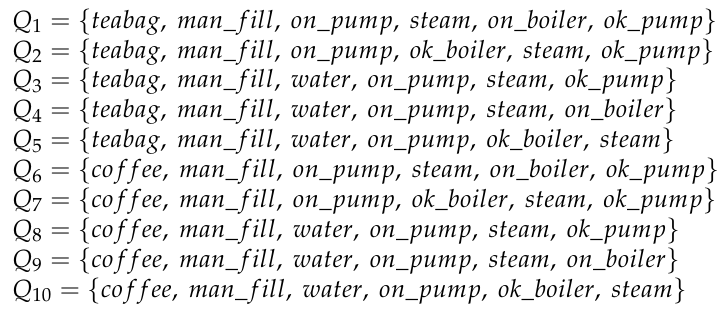
Figure 1. Knowledge Base for the espresso machine from [11].